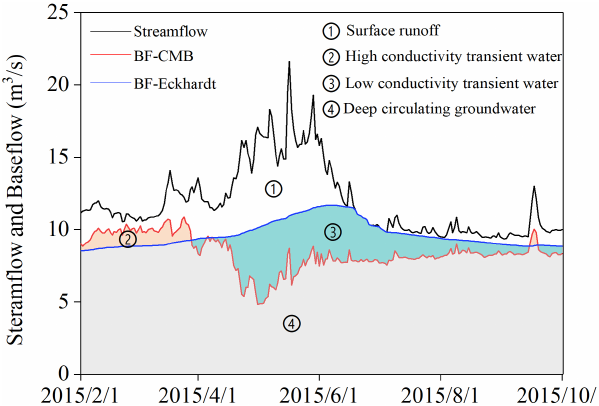
Figure 7. Schematic diagram showing the inherent deviation be- tween baseflow sequences generated by the Eckhardt and con- ductivity mass balance (CMB) methods which reflects different streamflow components using the United States Geological Survey (USGS) station 06037500 as an example. BF: